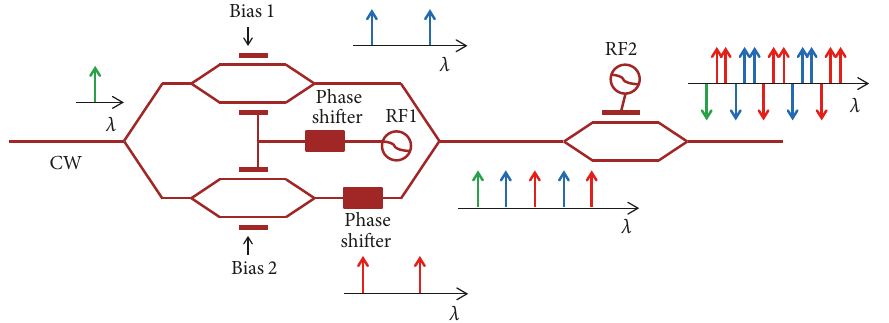
Figure 11: Scheme of the best candidate for the optical frequency comb generator (OFCG) to be implemented in the BHP generator(BHPG).